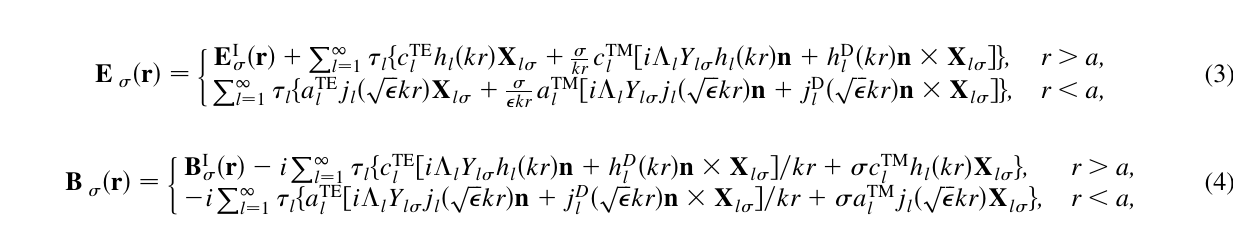
FIG. 1. Amplitudes of partial waves on the TE, l (cid:2) 22 , resonance.